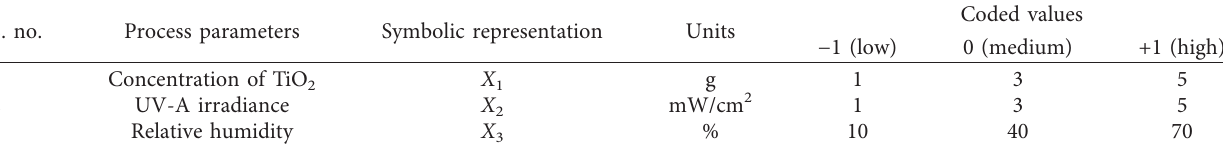
Table 1: Three levels of the process parameters used during the optimization process. S.